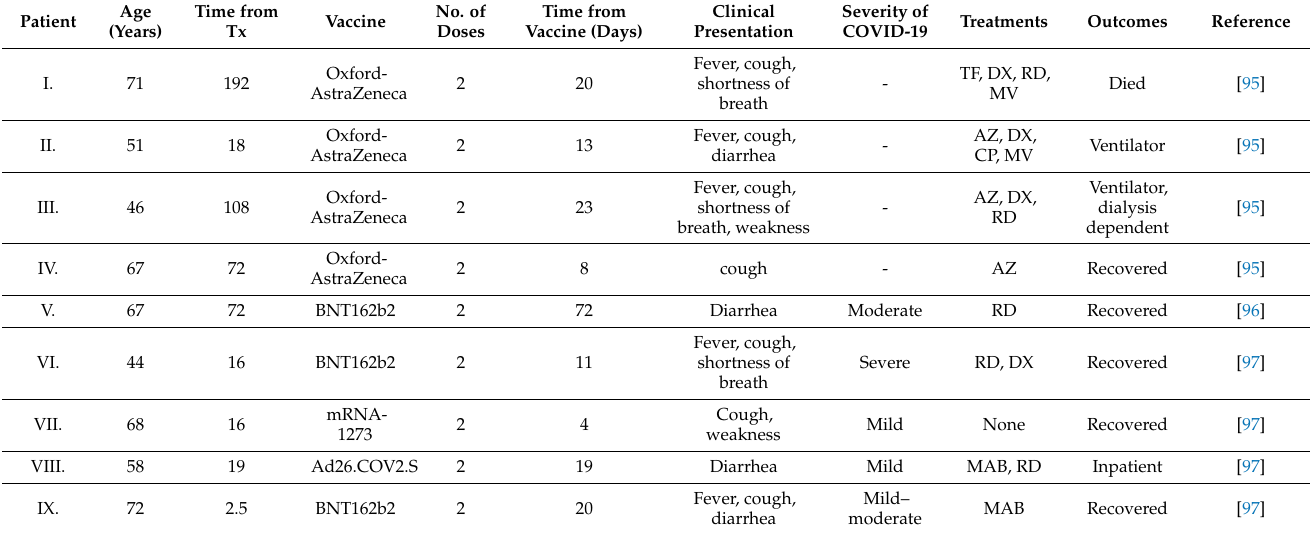
Table 2. Clinical presentation, treatments and outcomes of vaccinated COVID-19 in KTx